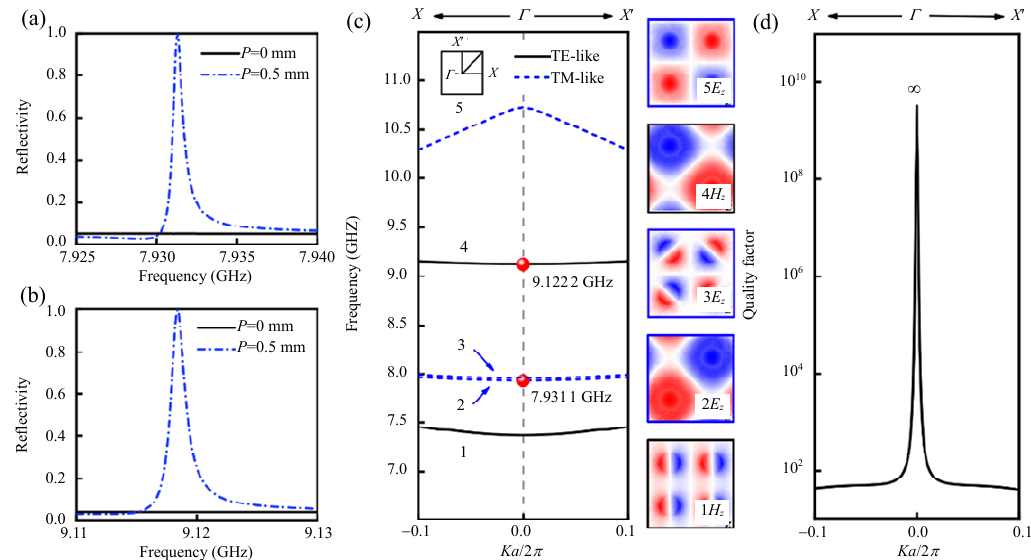
Fig. 2 Reflection spectra of modes at the metasurface: (a) reflection spectra of Mode 1 at symmetric ( P =0 mm) and asymmetric ( P =0.5 mm) metasurfaces, (b) reflection spectra of Mode 2 at symmetric ( P =0 mm) and asymmetric ( P =0.5 mm) metasurfaces, (c) band diagrams along X - Γ - X  ( ka/ 2 π ) of the metasurface. The out-of-plane components of their electromagnetic fields are shown in the right panel, and (d) quality factor distribution corresponding to the BIC